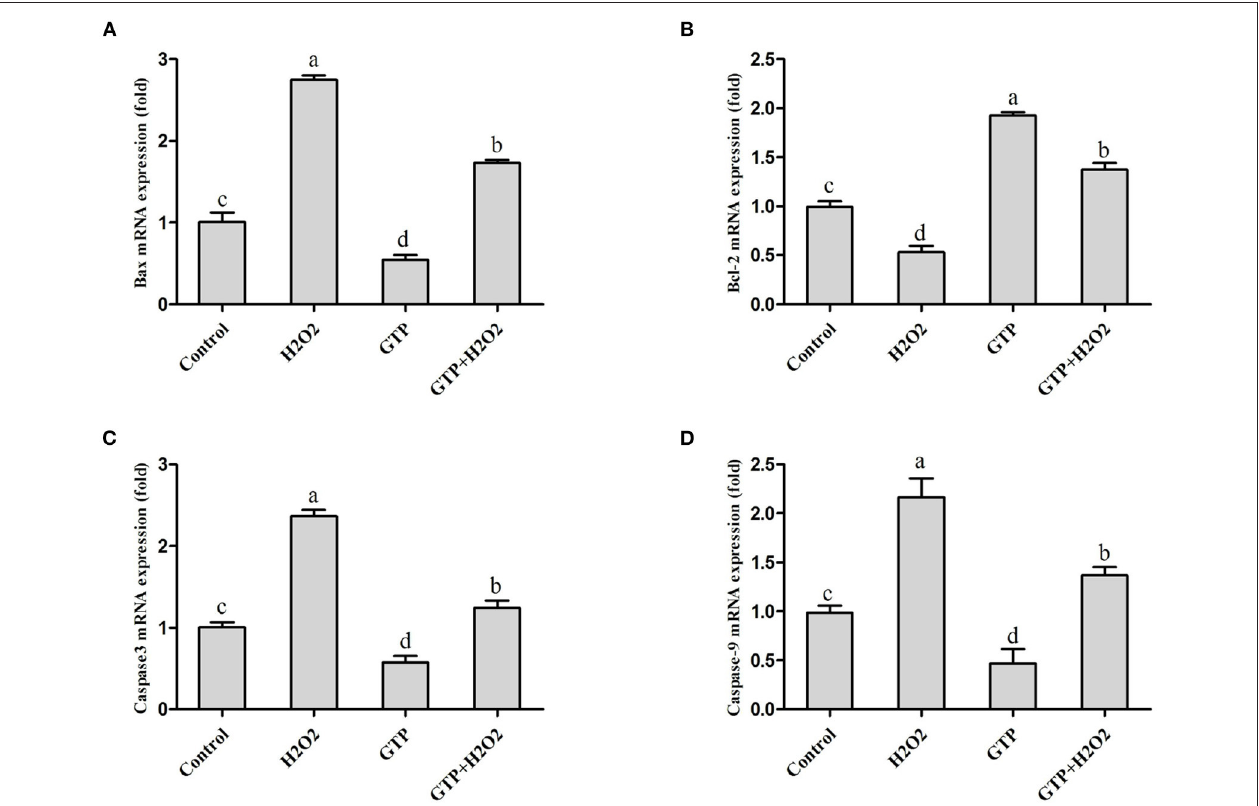
FIGURE 5 | GTP attenuated the H 2 O 2 -activated caspase pathway and apoptosis. BMECs were treated with H 2 O 2 (500 µ M) and/or GTP (100 µ g/ml) for 12h. (A) Bax mRNA level in BMECs, (B) Bcl-2 mRNA level in BMECs, (C) Caspase-3 mRNA level in BMECs, and (D) caspase-9 mRNA level in BMECs. a,b,c,d, the adjacent lowercase letters indicate significant difference, the alternate lowercase letters indicate extremely significant difference, and the same lowercase letters indicate insignificant